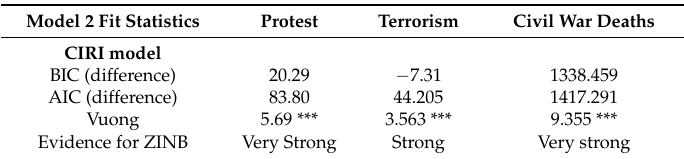
Table A2. Model fit